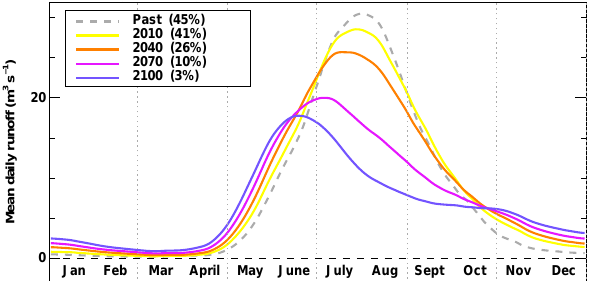
Fig. 8. Evolution of the runoff regime in the Mauvoisin region for the reference period and four time snapshots in the future averaged over ± 5yr. Numbers in brackets refer to the percentage of glacier cover.